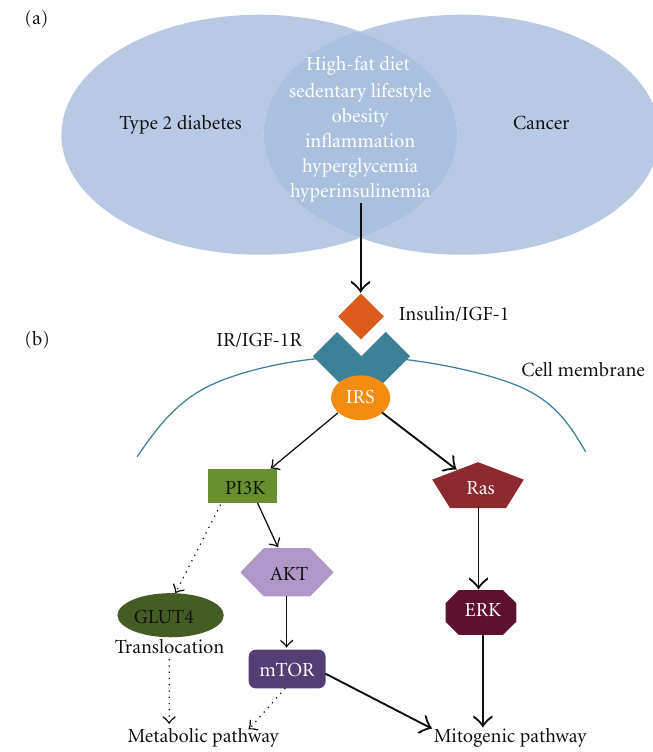
Figure 1: The “big picture” between DM2 and cancer. (a) The shared metabolic factors underlying both DM2 and cancer, including visceral adiposity, inflammation, hyperglycemia, and hyperinsulinemia lead to (b) increased insulin receptor substrate (IRS) stimulating the phosphorylation of Ras signaling proteins and potentially increasing tumor cell growth and proliferation. IRS-associated PI3K signaling is compromised by insulin resistant states, such as in DM2, and downstream GLUT4 translocation is disrupted. This disruption drives PI3K signaling towards AKT/mTOR. AKT and mTOR can a ff ect both the metabolic and mitogenic pathway, but because of the signaling dysfunction, AKT and mTOR are driven towards the mitogenic